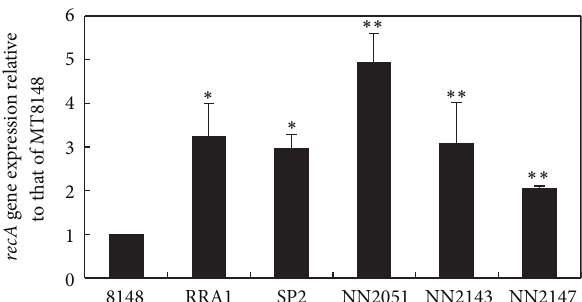
Figure 4: recA expression in all strains was examined by RT-PCR. There were statistically significant differences between MT8148 and the other strains ( ∗ 𝑃 < 0.05 , ∗∗ 𝑃 < 0.001 , Fisher’s